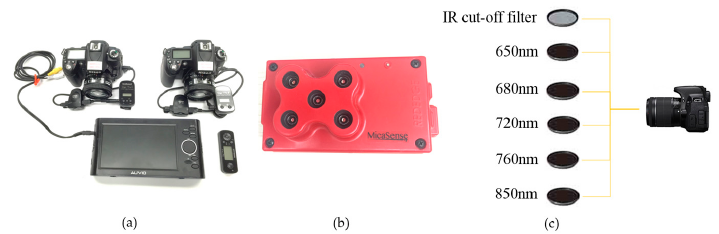
Figure 1. Commonly-used multispectral cameras with frame sensors: ( a ) two-camera imaging system [8], consisting of two consumer-grade Nikon D90 cameras with Nikkor 24 mm lenses, two Nikon GP-1A global positioning system (GPS) receivers, a 7-inch portable liquid crystal display (LCD) video monitor, and a wireless remote shutter release; ( b ) a five-band Rededge imaging system with five imaging units (MicaSense, Inc., Seattle, WA, USA); and ( c ) a single-camera imaging system based on changeable filters, namely, a Nikon D7000 with changeable filters) [13].